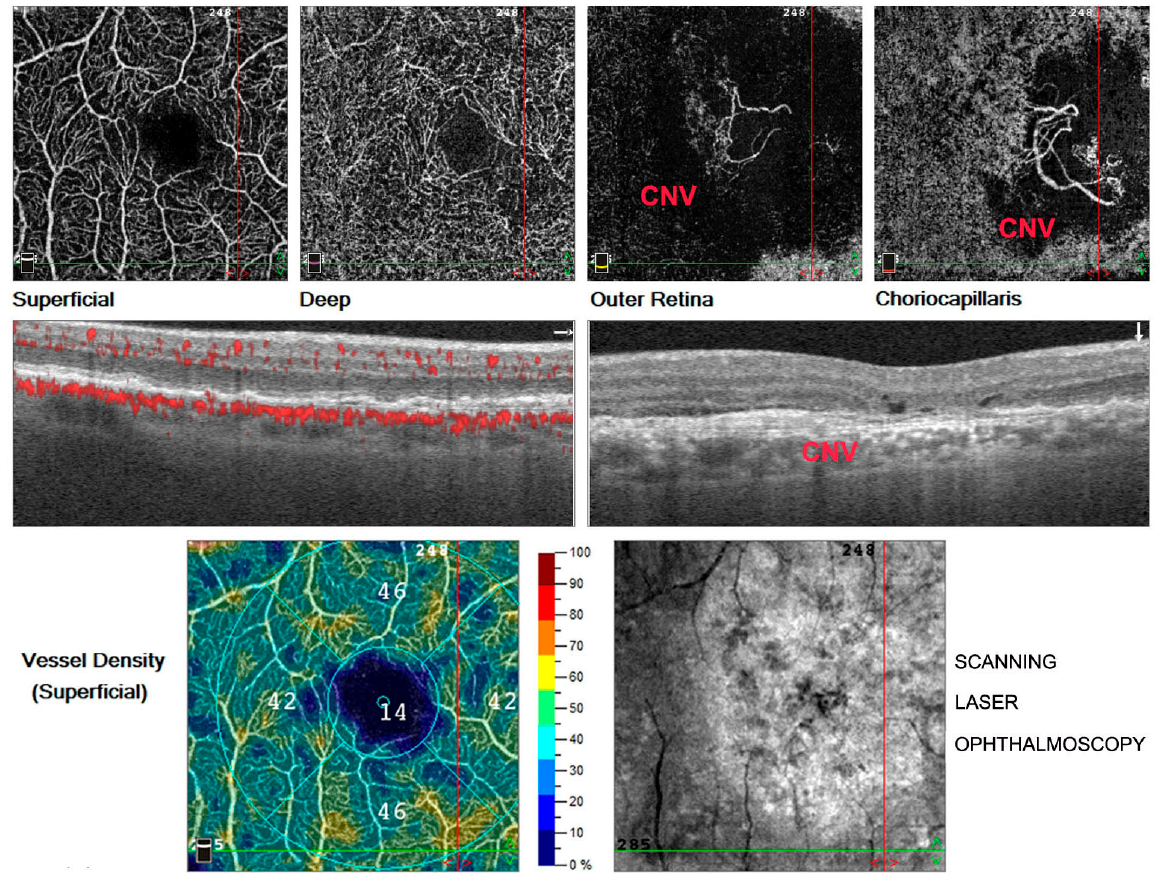
Figure 2. Optical coherence tomography angiography (OCTA) in right eye. Images of a patient suffering from wet age-related macular degeneration (AMD) characterized by a phenomenon of abnormal vascular proliferation in the choriocapillaris layer and consecutive choroidal neovascular membrane (CNV) development in the macular region, clearly evident in the last image at the top right.